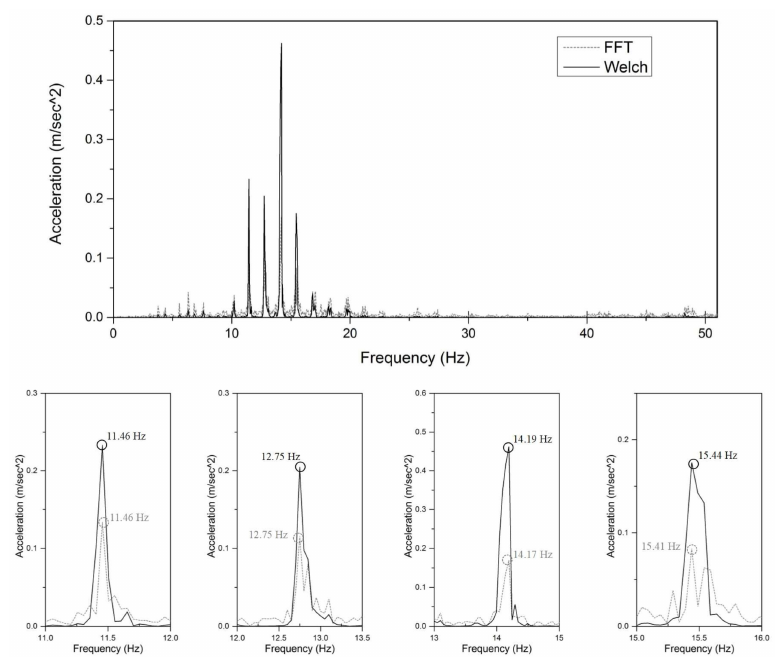
Figure 7. Difference between the single Fourier spectrum and the spectrum obtained using Welch’s method: ( a ) comparison of the whole spectra and ( b ) magnified sections.